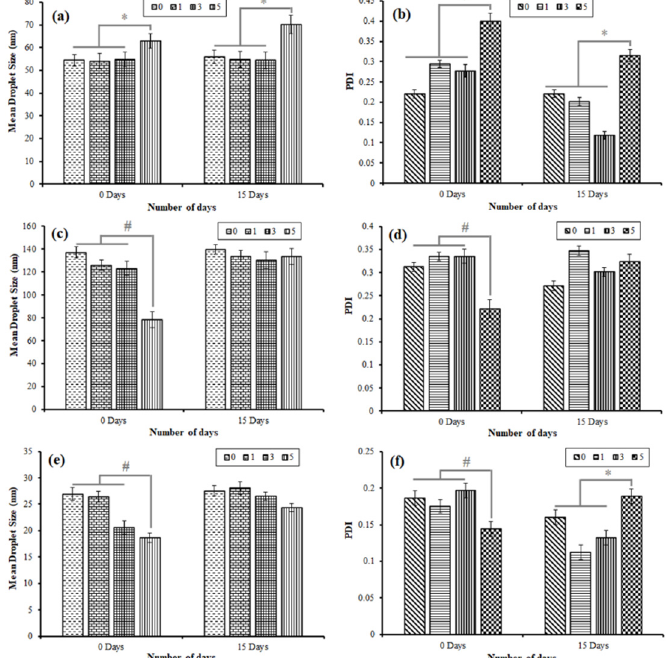
Figure 3. Impact of vortexing duration (0, 1, 3, and 5 min) ( a ) on droplet size for OA-based NE; ( b ) on PDI for OA-based NE; ( c ) on droplet size for C90-based NE; ( d ) on PDI for C90-based NE; ( e ) on droplet size for EO-based NE; ( f ) on PDI for EO-based NE. * Increase is statistically significant ( p < 0.05) with the increase of the vortexing duration; # Decrease is statistically significant ( p < 0.05) with the increase of the vortexing